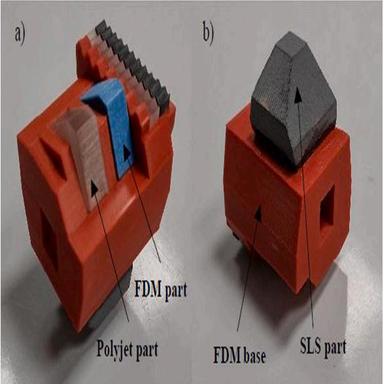
Designed assembly. a) Upper view. b) Lower view.